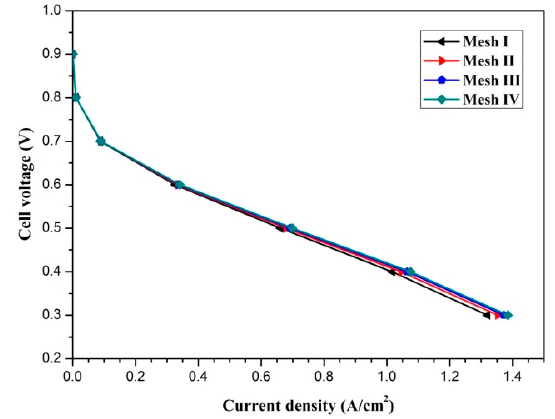
Figure 2. The mesh independence test.